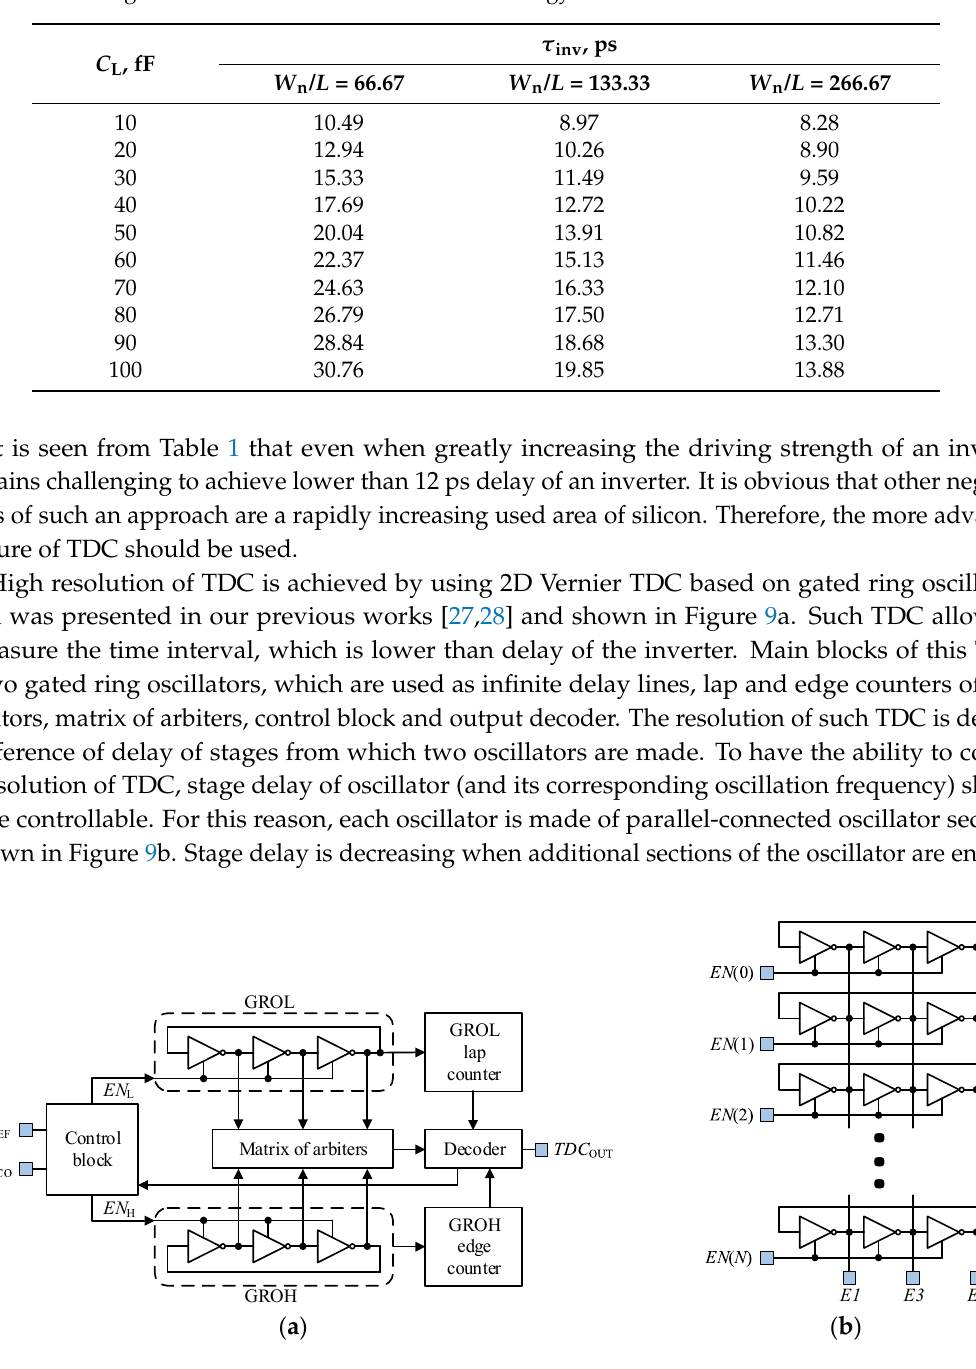
Figure 9. ( a ) Structure of proposed 2D Vernier time to digital converter based on gated ring oscillators. GROL—lower frequency oscillator, GROH—higher frequency oscillator; ( b ) Structure of gated ring oscillators used in TDC.